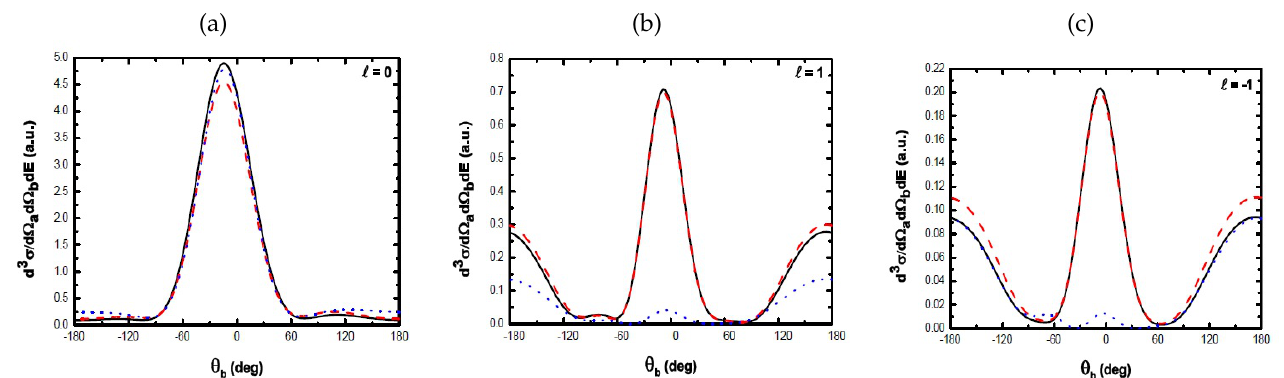
Figure 1. Triple-differential cross-sections corresponding to the laser-assisted electron-impact ionization process of atomic hydrogen as a function of the ejected angle θ b . The incident electron energy is E k ergy is E k = 5 eV, and the scattering angle is θ a = 5 ◦ . The laser is set to to 1.17 eV and the electric field strength is b E = 1 · 10 7 V/cm . The laser polarization vector of the field is set parallel to the wave vector of the incident electron. Red, dashed line: Second-Born approximation results; Continuous line: First-Born approximation results. Blue, dotted line: results obtained by ignoring the dressing of the target. ( a ) l = 0: no-photon net exchange; ( b ) l = 1 one photon absorption; ( c ) l = − 1 one photon emission (taken from